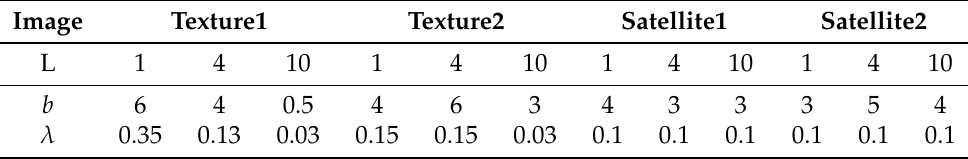
Table 1. The values of b and λ for numerical simulations on test images in Figure 2.